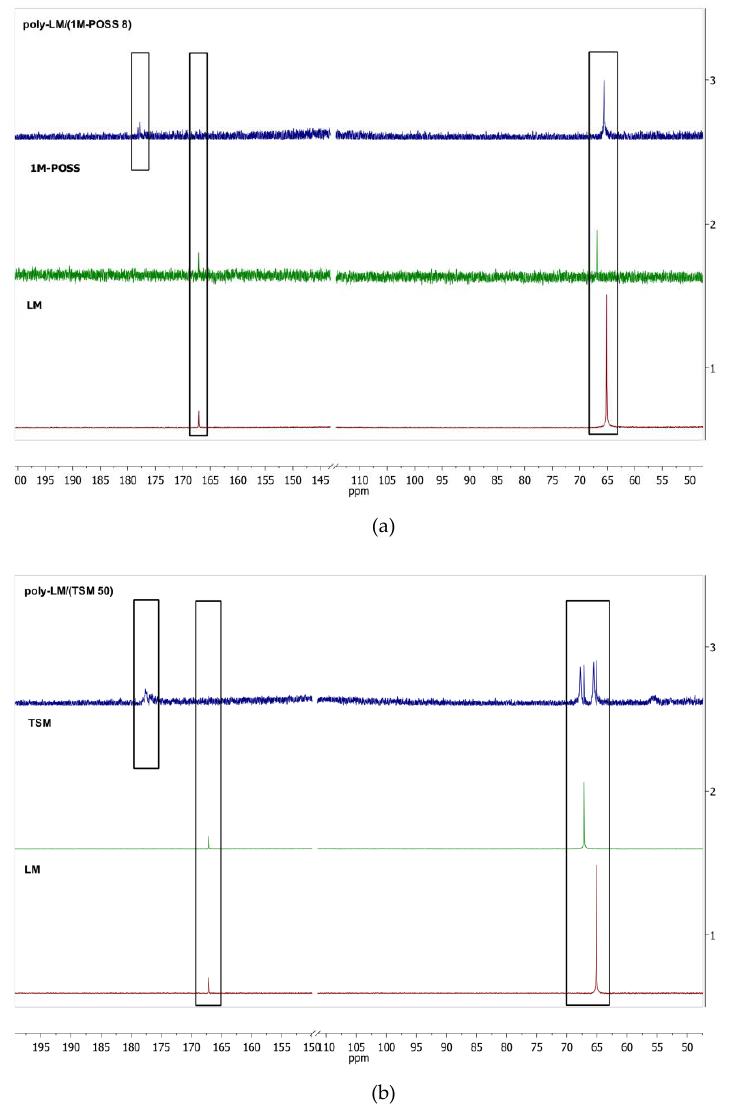
Figure 4. 13 C NMR stacked spectra of the LM monomer, the modifiers, and the copolymers containing ( a ) 8 mol % of 1-M POSS, ( b ) 50 mol % of TSM.